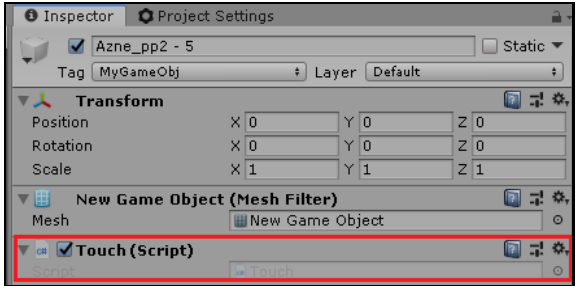
Figure 10. Script attached with one of the game objects which